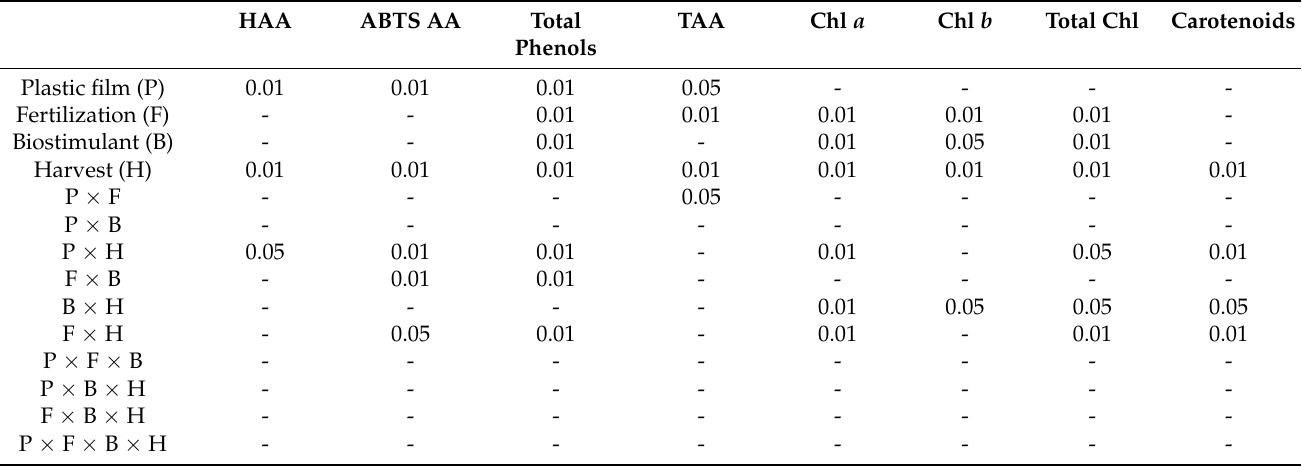
Table 3. Analysis of variance of hydrophilic antioxidant activity (HAA), ABTS antioxidant activity (ABTS AA), content of total phenols, total ascorbic acid (TAA), chlorophyll a (Chl a ) and b (Chl b ), total chlorophyll and carotenoids, as affected by the different experimental factors: significance of main factors and